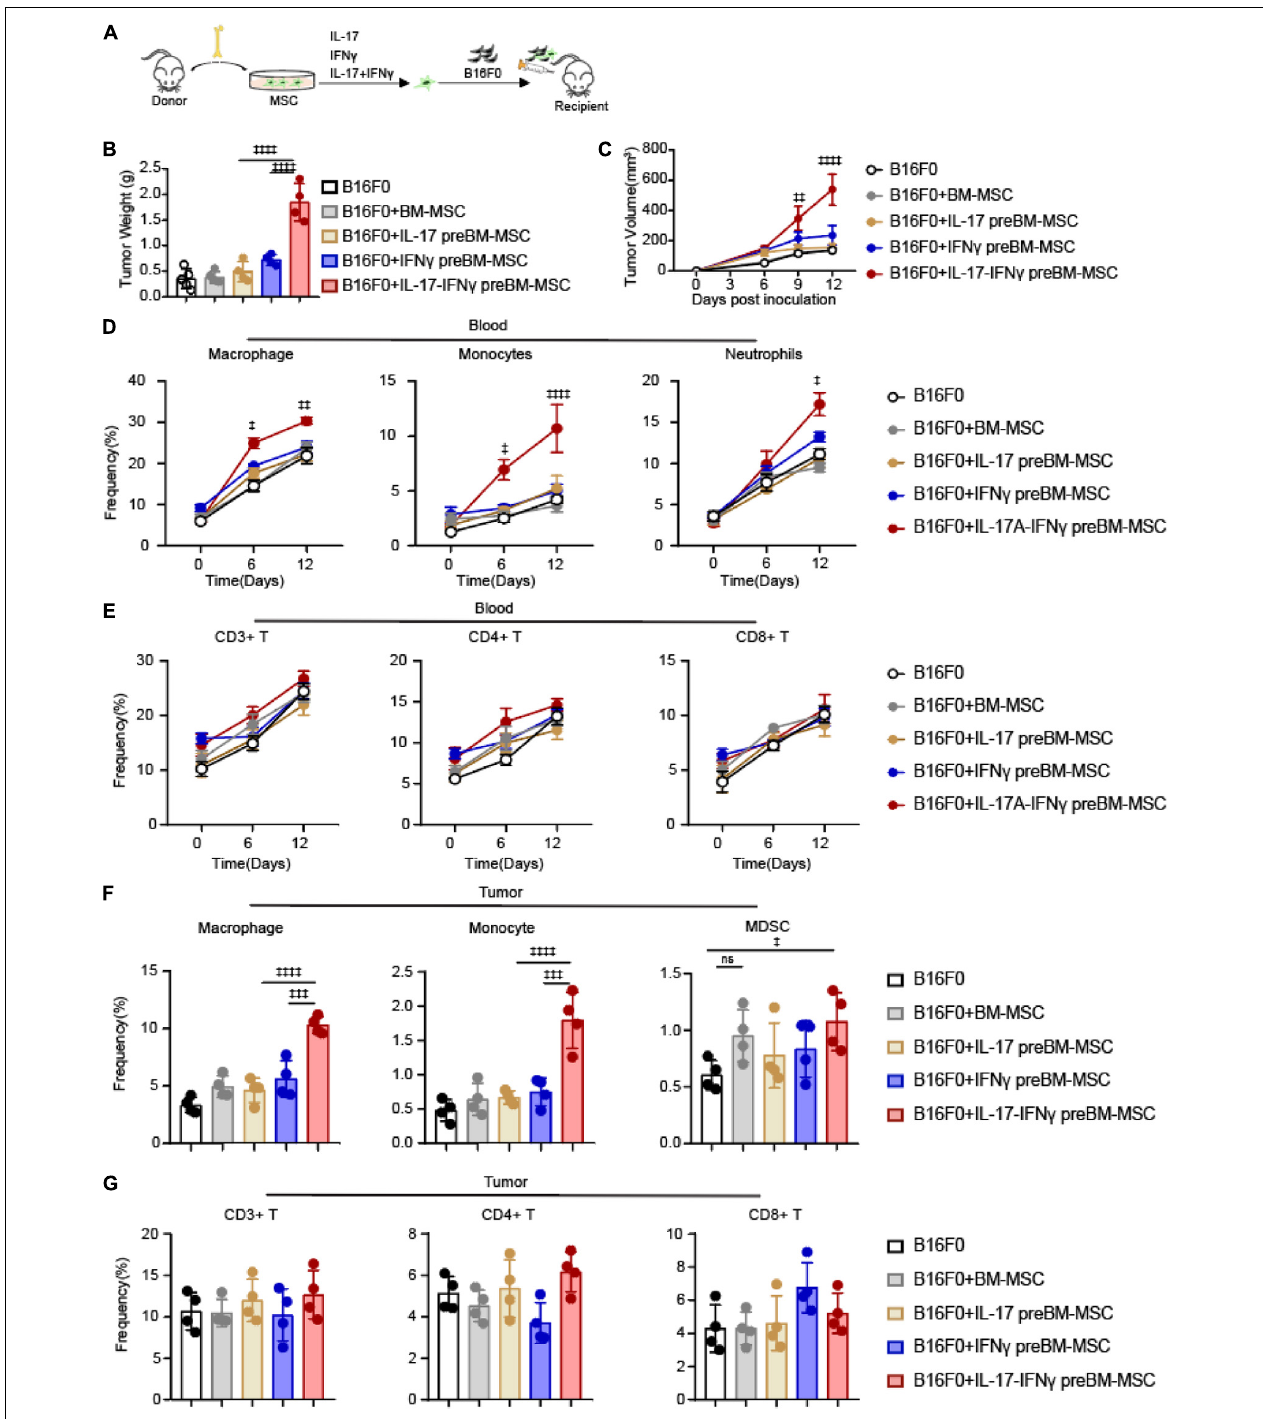
FIGURE 1 | IL-17 and IFN γ transform BMSCs into TA-MSCs to facilitate melanoma progress in vivo . (A) Schematic depicting the strategy to investigate the tumor-promotion function of IL-17 and IFN γ transformed BMSCs in murine melanoma. (B,C) Tumor weight (B) and tumor growth curve (C) in melanoma mice inoculated with B16F0 cells alone or with IL-17 and/or IFN γ pre-treated BMSCs ( n = 4–5). (D,E) The percentage of circulated macrophages, monocytes, neutrophils (D) , and T cells (E) in the peripheral blood. (F,G) The frequency of resident macrophages, monocytes, MDSCs (F) , and T cells (G) in the tumor tissues in melanoma mice inoculated with B16F0 cells alone or with IL-17 and/or IFN γ pre-treated BMSCs ( n = 4). Data represent mean ± SD of 3 independent experiments. ‡ p < 0.05, ‡‡ p < 0.01, ‡‡‡ p < 0.001, ‡‡‡‡ p < 0.0001. ns, not significant.